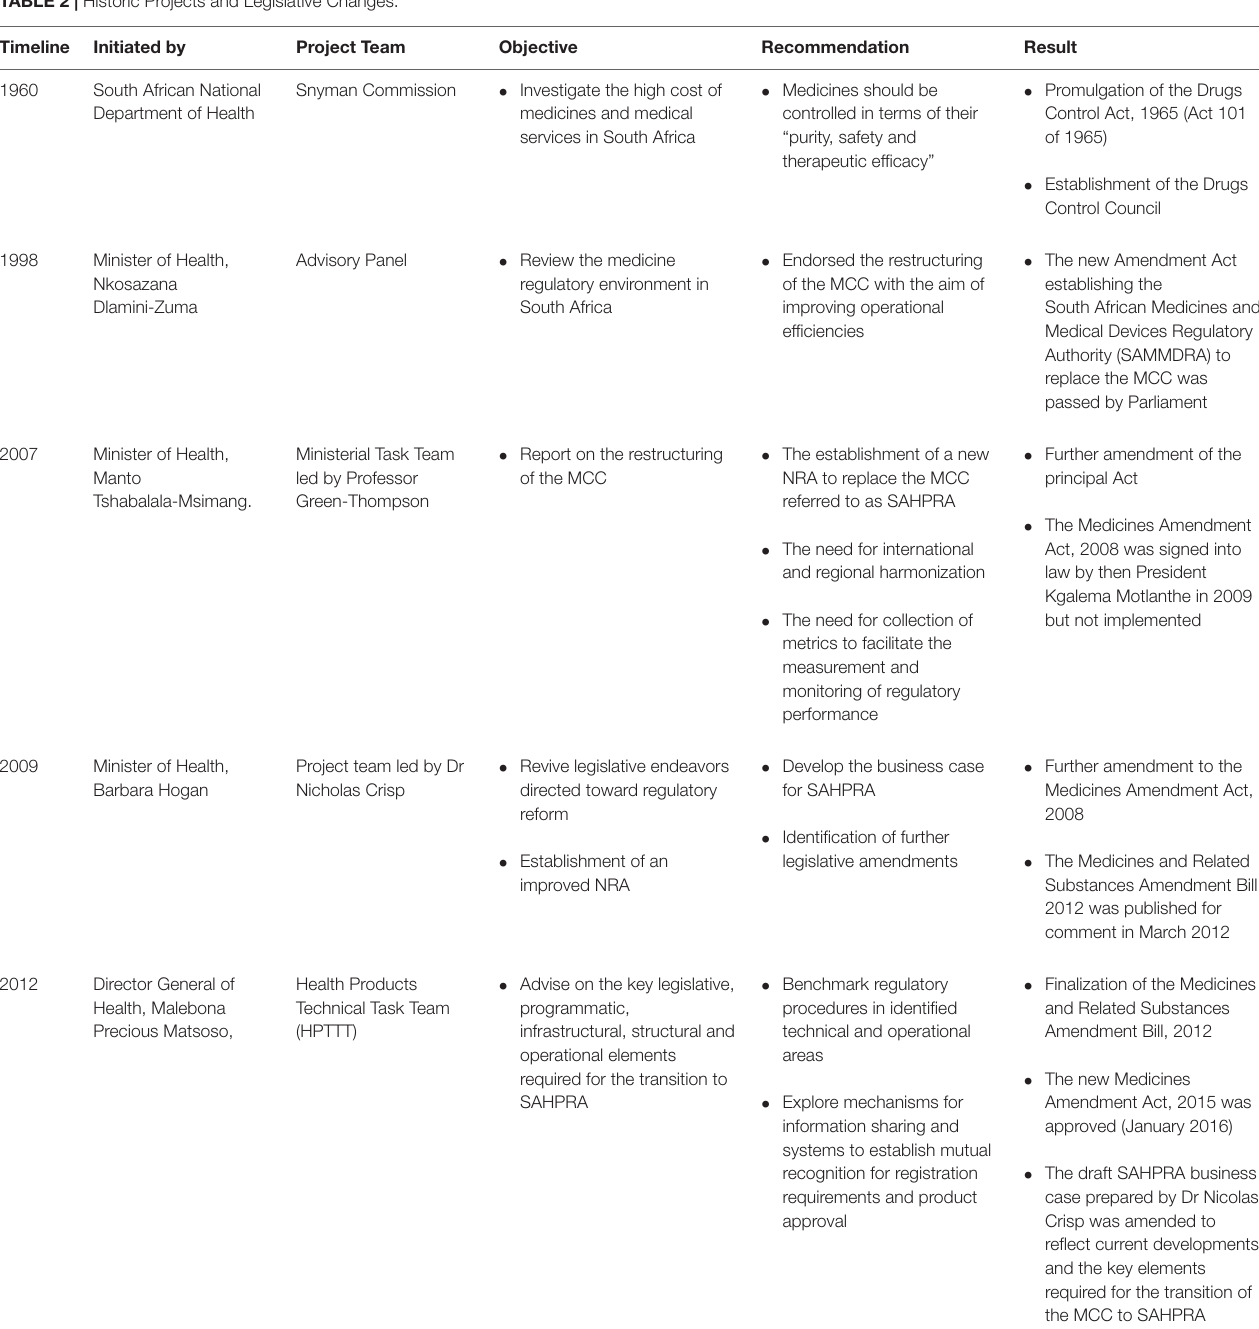
TABLE 2 | Historic Projects and Legislative